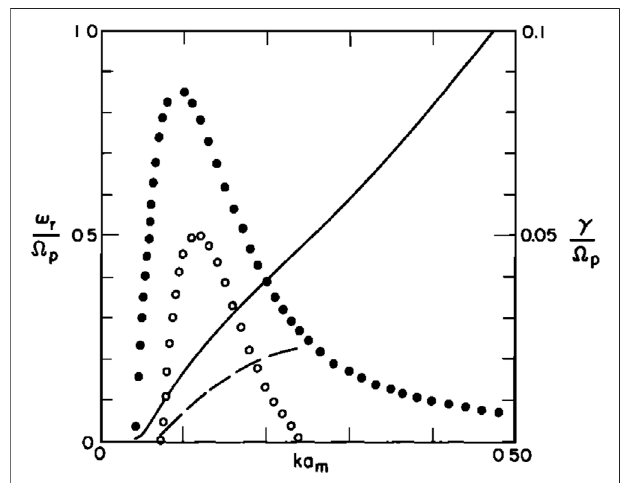
FIGURE2| Complexfrequency( ω = ω r + i γ )computedfromlineartheory for the right-hand resonant ion beam instability as a function of wavenumber (k).The beam density is1% of the background ion density and beam speed is 10 v A (v A = Alfven speed). The frequencies are normalized by the background ion cyclotron frequency ( Ω i ) and the wavenumbers to the background ion gyroradius ( a i ). Two cases are shown: ( a ) parallel propagation ( θ = 0 ° ) -- real frequencies are given by the solid line, growth rates by the solid circles; ( a ) oblique propagation ( θ = 45 o ) -- real frequencies are given by the dashed line, growth rates by the open circles. Figure is reproduced from Gary et al., 1981, with permission from The American Geophysical